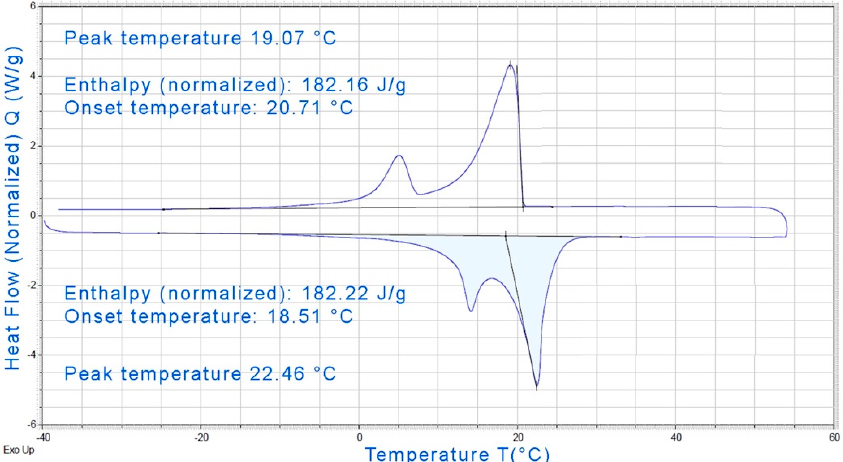
Figure 5. Differential scanning calorimeter test results of the PCM.